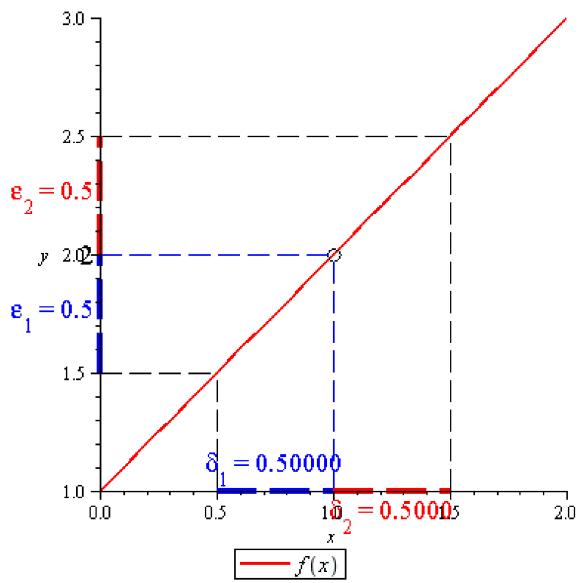
Figure 1. Geometric Representation of the Limit of A